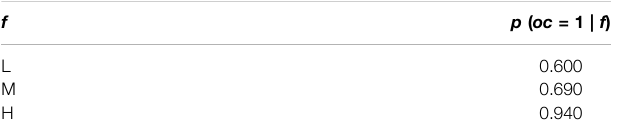
TABLE 1 | Main elements of the POMDP model for the collision avoidance problem. Occupancy model p ( o | f ): probability of subsegment occupancy given segment dif fi culty.